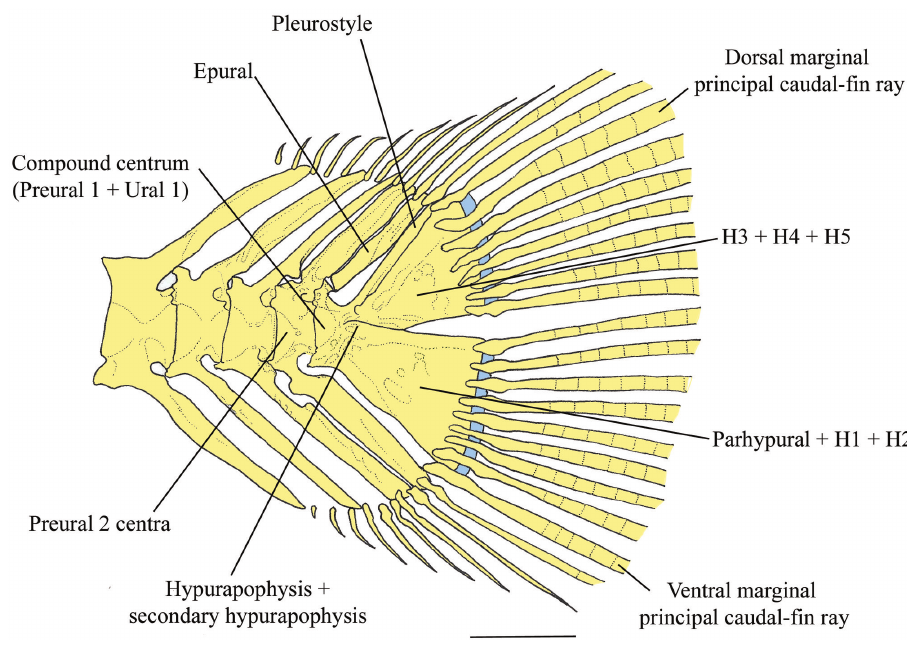
FIGURE 5 | Caudal-fin skeleton of Rhyacoglanis rapppydanielae , paratype, INPA 7957, 33.3 mm SL, rio Tocantins, state of Pará, Brazil. H1–5 = hypurals 1 to 5. Scale bar = 1 mm.